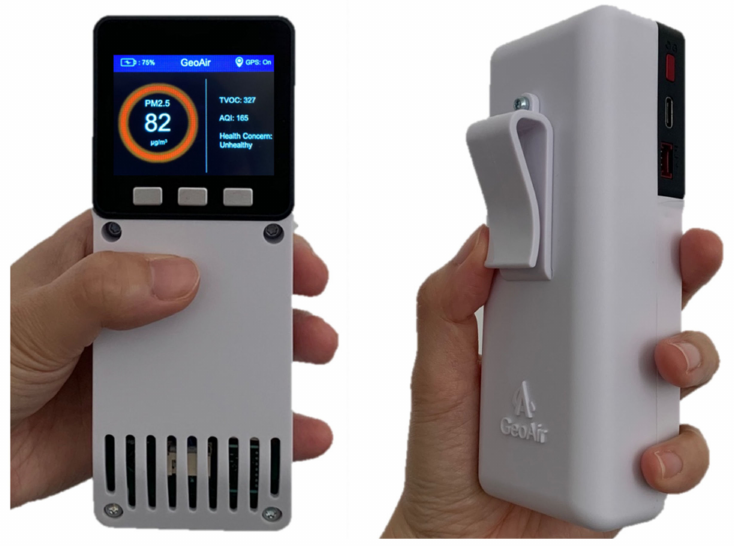
Figure 2. GeoAir2: A portable, GPS-enabled, low-cost air pollution